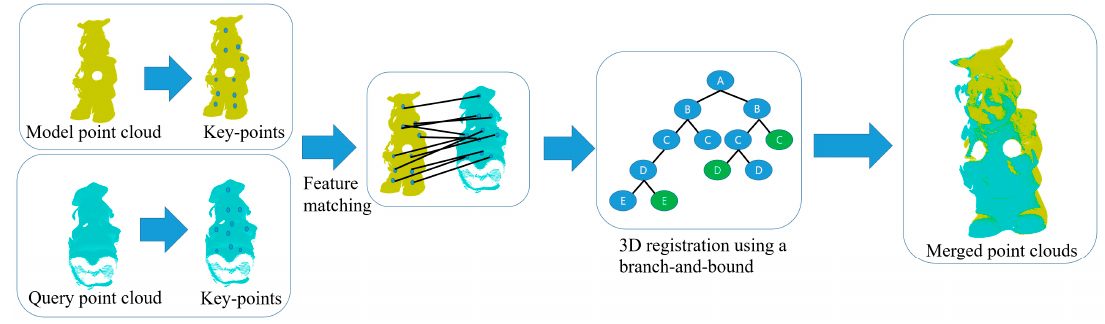
Figure 1. The pipeline of the 3D feature-based registration using the proposed method.